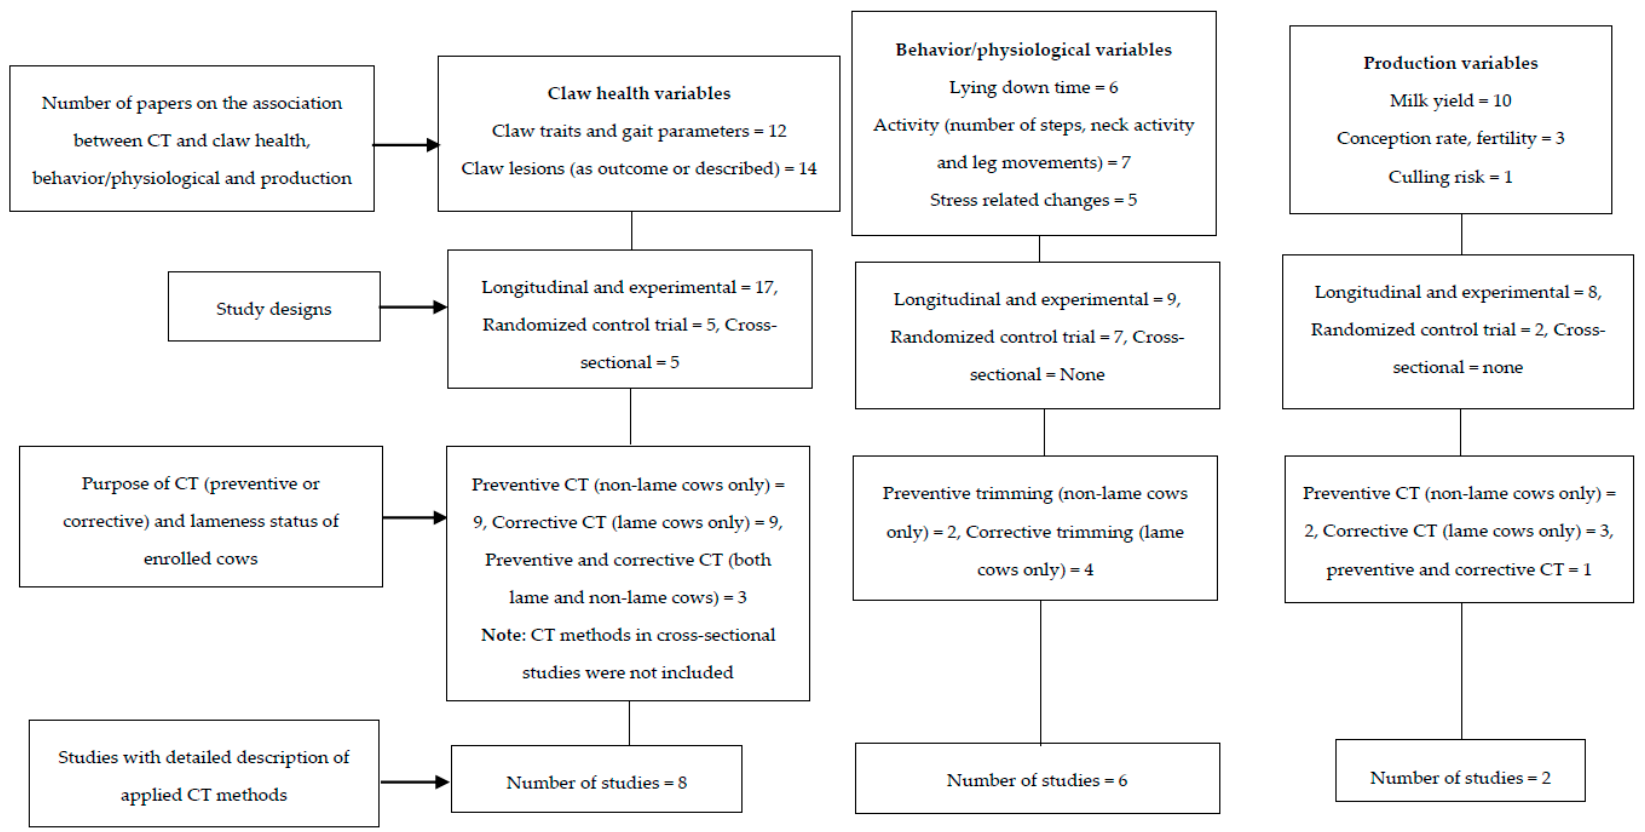
Figure 2. Summary of reviewed papers reporting the association between claw trimming and/or claw health, physiological, behavioral, and production variables in dairy cows, with information on study designs, rationale for and description of CT methods. The total number of studies in each of the uppermost boxes (claw health, behavior/physiological, production variables) could be greater than the numbers provided in the respective study designs, since some papers were counted more than once.